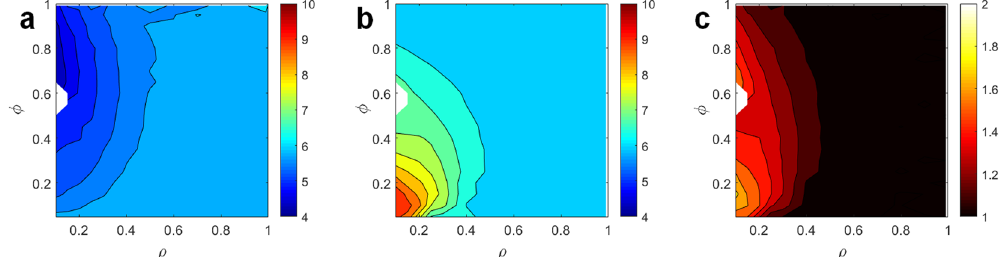
Figure 2. Mean number of nearest neighbors. ( a ) Mean number of nearest neighbors for high-ranking males, and ( b ) for low-ranking males. ( c ) ratio between the mean number of nearest neighbors for low-ranking relative to high-ranking males. All quantities are plotted as a function of the fraction φ of low-ranking males and the ratio ρ between the weights. The white regions correspond to combinations of parameters where a stable configuration was not attained after 4 × 10 6 simulation